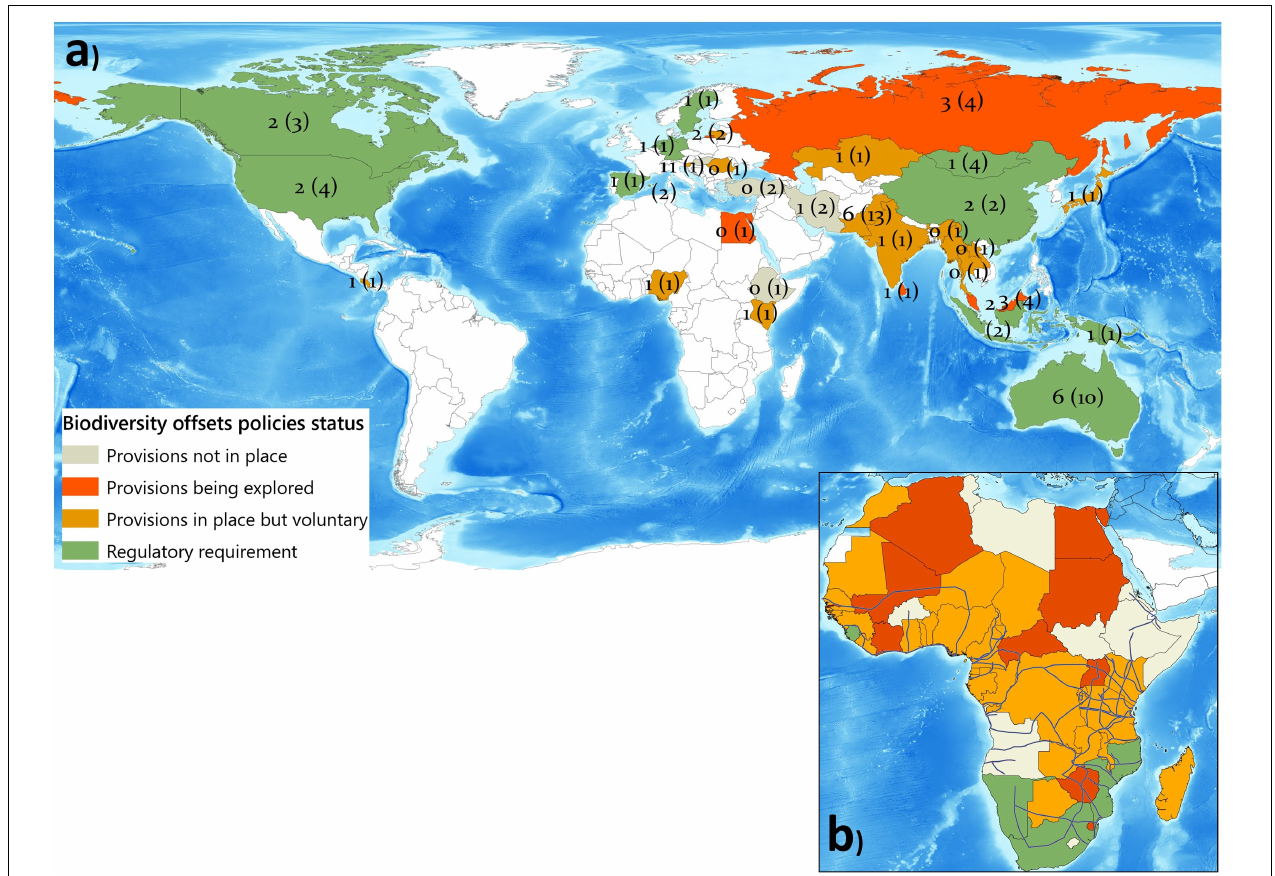
FIGURE 6 | Number of country case studies proposing biodiversity mitigation measures in each country and, between brackets, total of country case studies. Colors indicate the status of national biodiversity offset policies according to the Global Inventory of Biodiversity Offset Policies (GIBOP, 2020), shown for country case studies picked up by our review only. (a) Global overview of the results per country of this review. (b) Case study for the African continent where blue lines represent 33 ongoing or planned development corridors (Laurance et al., 2015). The map shows that most countries in Africa where development corridors